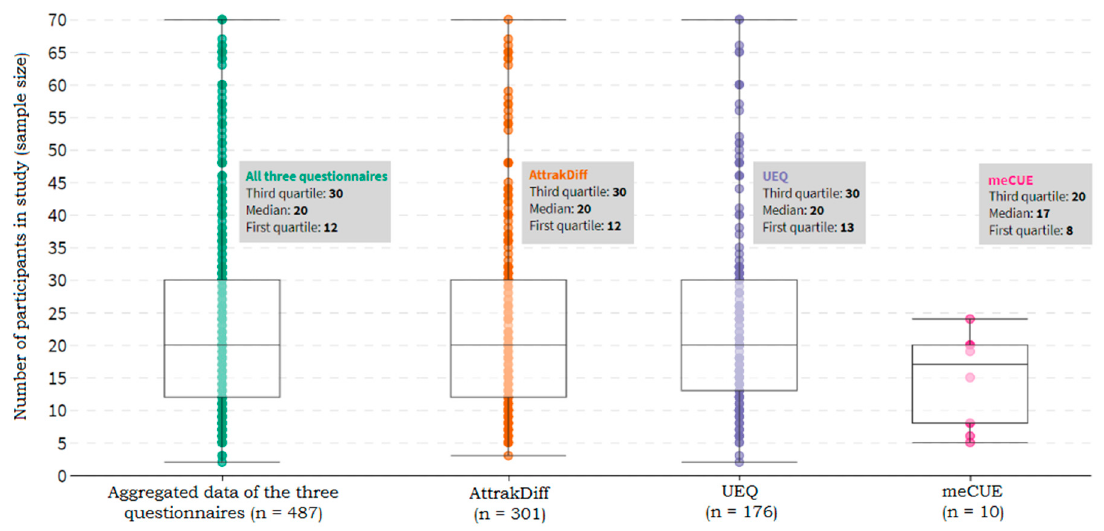
Figure 5. Number of participants on the studies without considering 61 identified outliers: 21 studies with samples between 72 and 100 participants, 27 studies with samples between 101 and 186, and 13 studies with samples greater or equal to 200. Additionally, in five studies, the sample size could not be